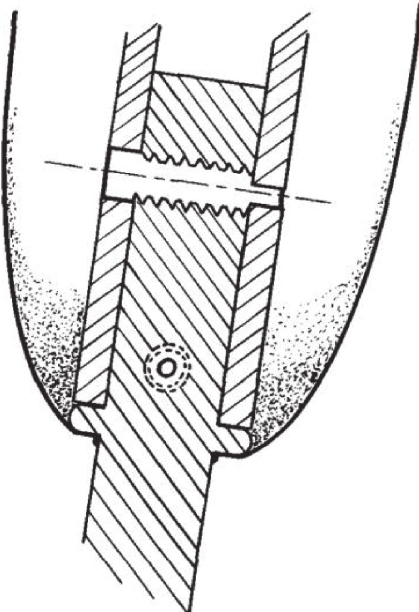
Figure 7: Schematic of the first skeletally implanted transcutaneous prosthetic anchor documented to be used in a human, designed by Dr. G. D¨ummer in 1946. The retention mechanism was the two cross-pins through the bone and implant (reproduced with permission from Murphy E. F. History and philosophy of attachment of prostheses to the musculo-skeletal system and of passage through the skin with inert materials. Journal of Biomedical Materials Research . 1973 May;